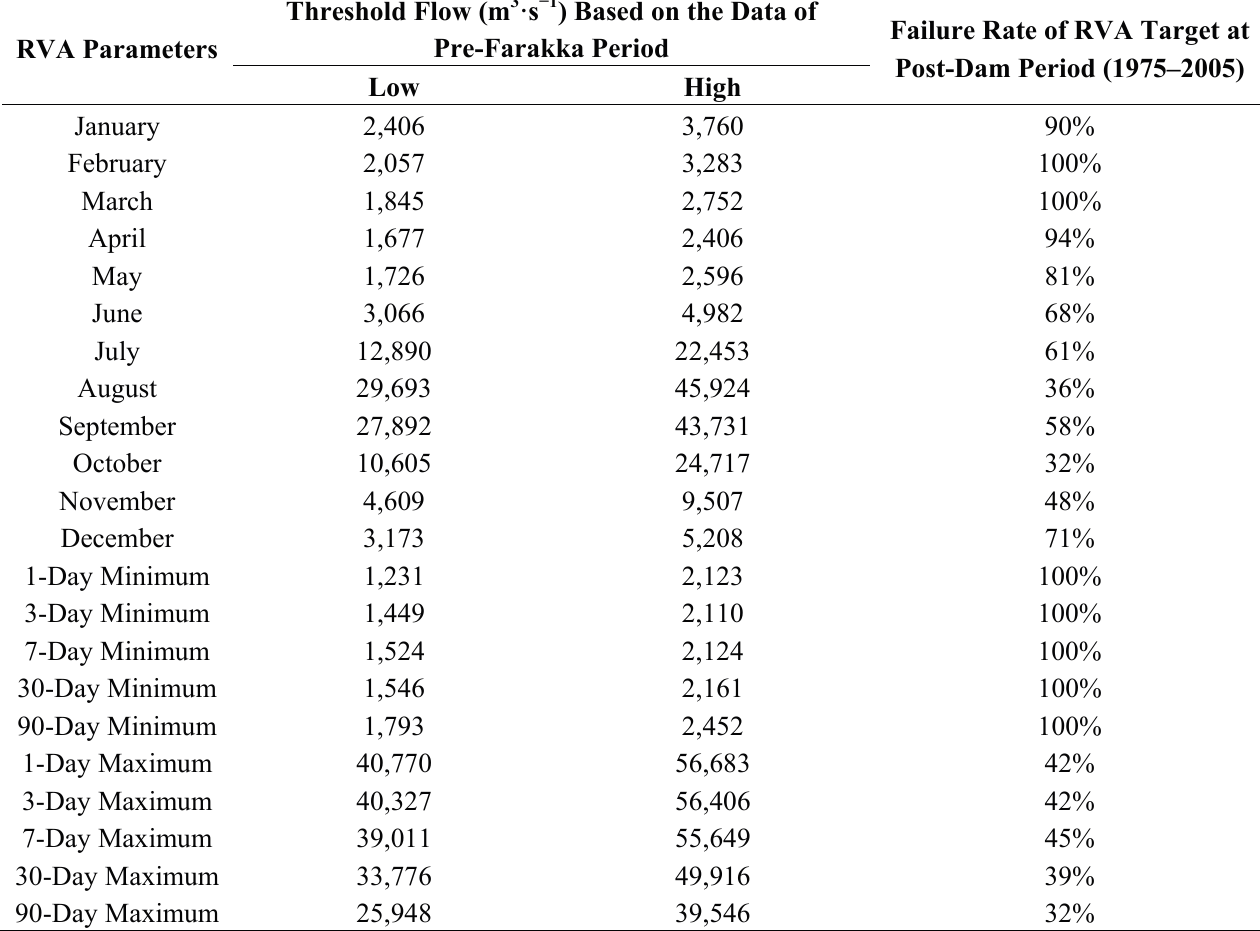
Table 3. Investigation of the failure (Column 4) of the RVA target of the post-Farakka period